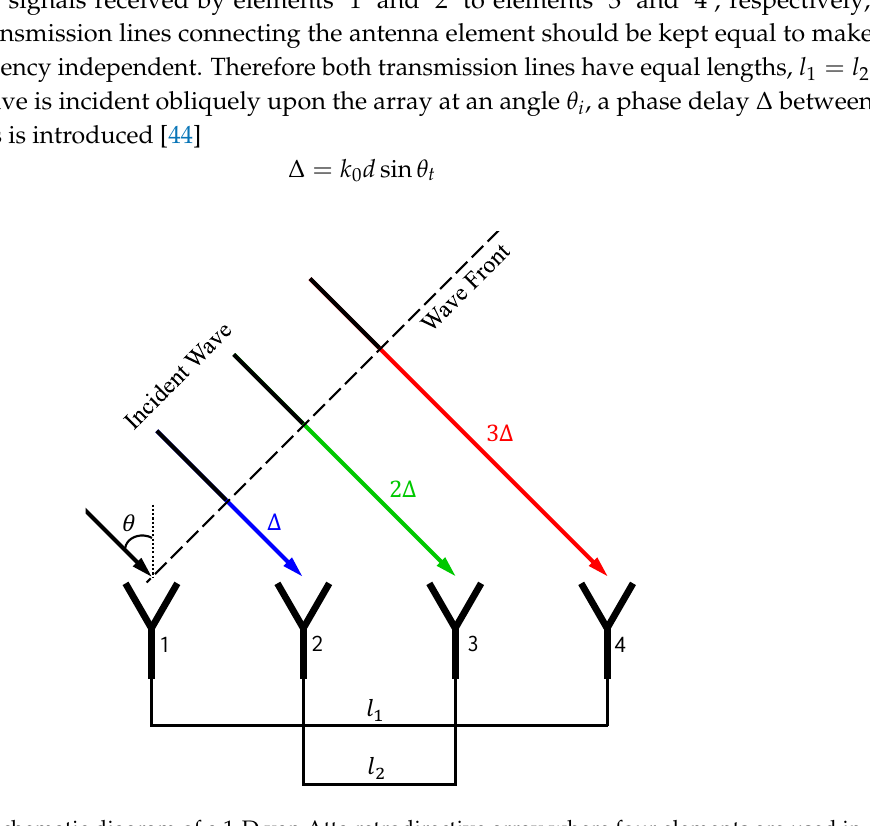
Figure 14. A schematic diagram of a 1-D van Atta retrodirective array where four elements are used in the